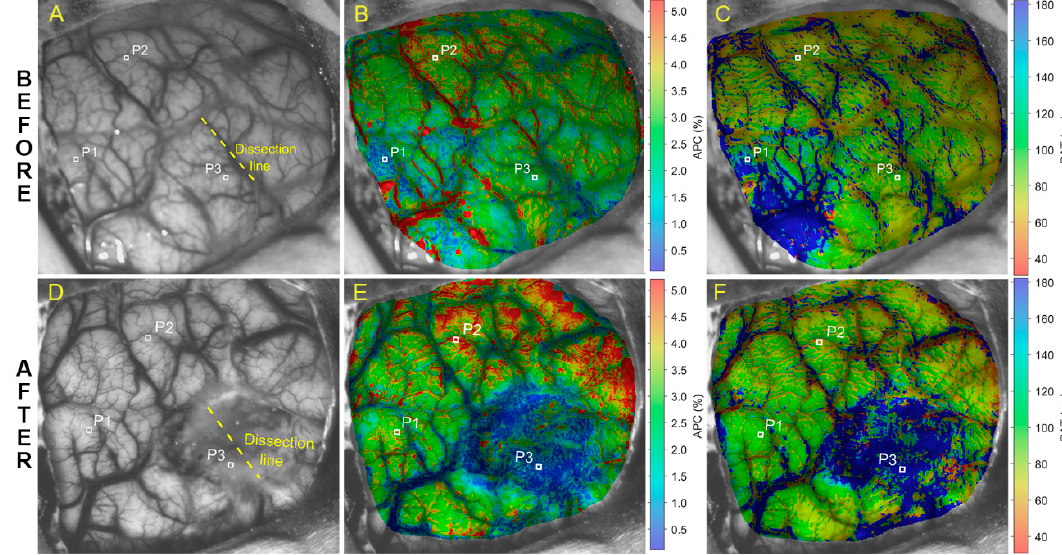
Figure 1. Mapping the blood pulsations parameters in the brain cortex in the case of a patient with a tumor: The upper and lower rows of images of the open brain were obtained before and after tumor resection, respectively. Panels ( A ) and ( D ) show photographs of the open brain with the dissection area indicated by a yellow line and three selected regions of interest (ROIs) marked as P1, P2, and P3. Spatial distributions of amplitude of the pulsatile component (APC) and pulse arrival time (PAT) overlaid with still images of the open brain cortex are shown in ( B ), ( E ) and ( C ), ( F ), respectively. The color scales on the right side of images ( B ) and ( E ) show APC in percent, whereas that of images ( C ) and ( F ) is PAT in milliseconds.